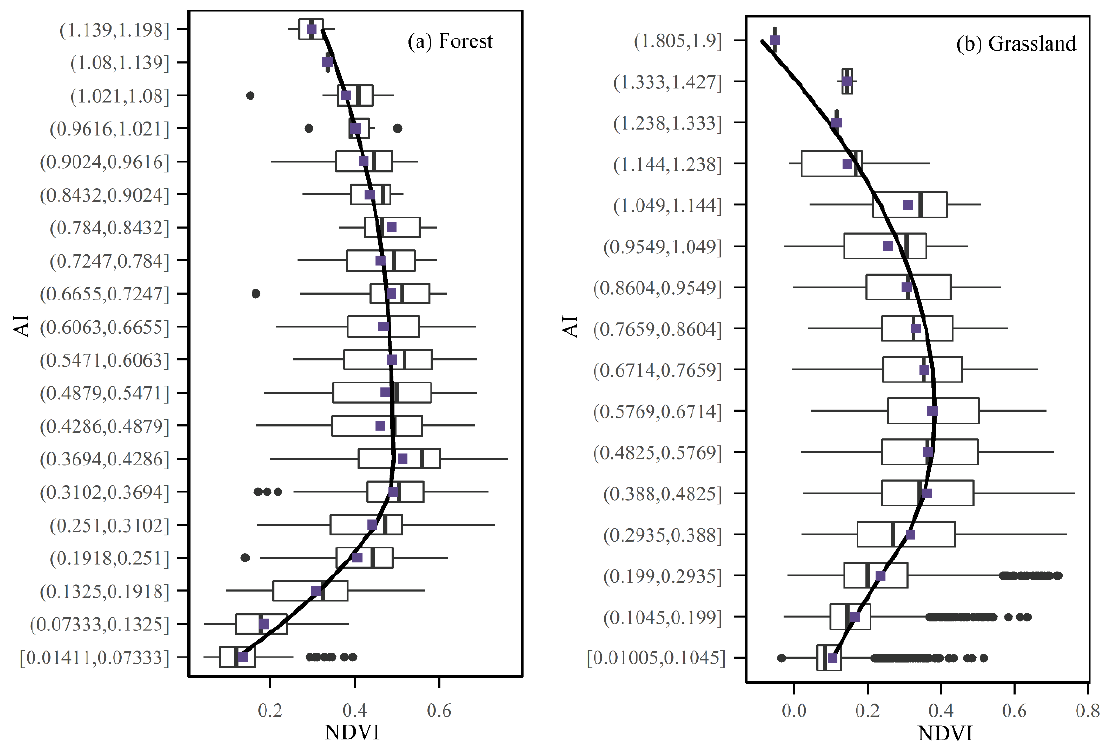
grassland NDVI. The NDVI of grassland remained stable at an AI of between 0.39 and 0.86, indicating that this range of AI is optimal for grassland.